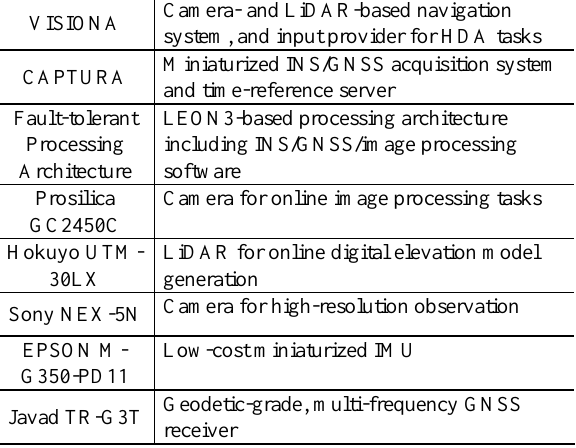
Table 1. Subsystems and sensors integrated in the UAV